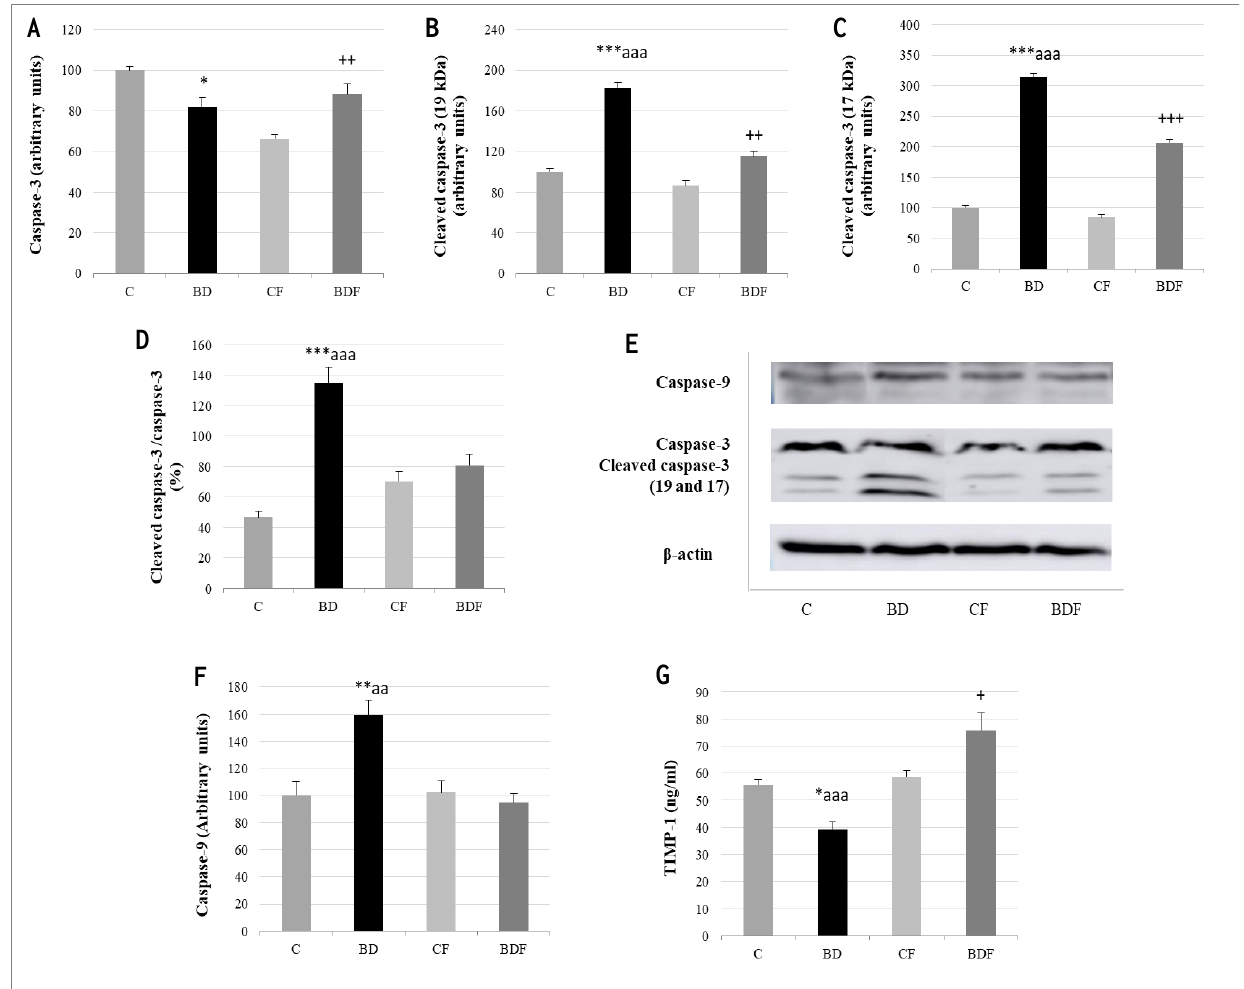
Figure 7. Apoptosis analysis in the liver of adolescent rats. Caspase-3 ( A ), cleaved caspase-3 (19kDa: ( B ) and 17 kDa: ( C )) expression (expressed as percent arbitrary relative units, referring to values in control animals which were defined as 100%). Ratio of activated caspase-3 ( D ). Representative Western blot for the expressions of caspase-3, cleaved caspase-3, caspase-9 and β -actin (as load control) ( E ). Caspase-9 expression (expressed as percent arbitrary relative units, referring to values in control animals which were defined as 100%) ( F ). Serum TIMP-1 levels (ng/mL) ( G ). The results are expressed as mean ± SEM and analysed by a multifactorial one-way ANOVA followed by Tukey’s test. The number of animals in each group is 6 and n = 12 for TIMP-1 analysis or n = 6 for caspase expression determinations. SEM: standard error of the mean. Groups: C: control